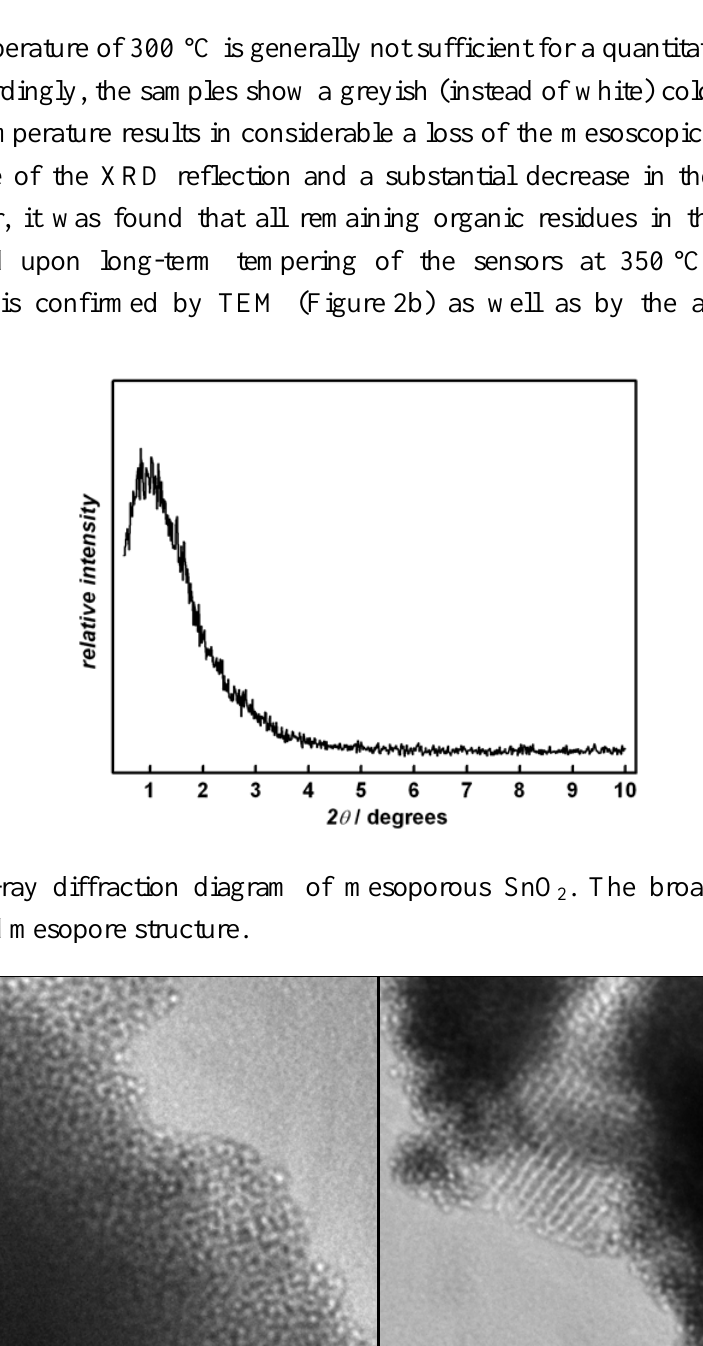
Figure 2. Transmission electron micrographs of mesoporous SnO (incomplete removal of CTABr from the pores) and (b) after long-term tempering at 350 °C (complete